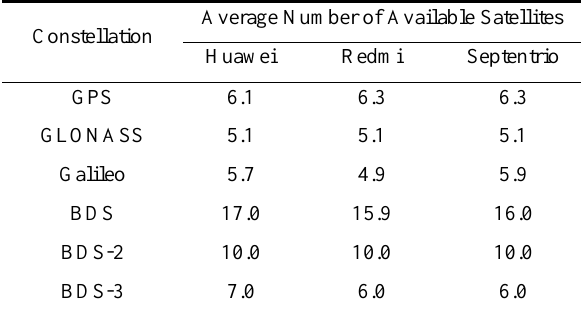
Figure 1. Experimental equiments. Table 1. The average number of available satellites for velocity determination in single-constellation scenarios.